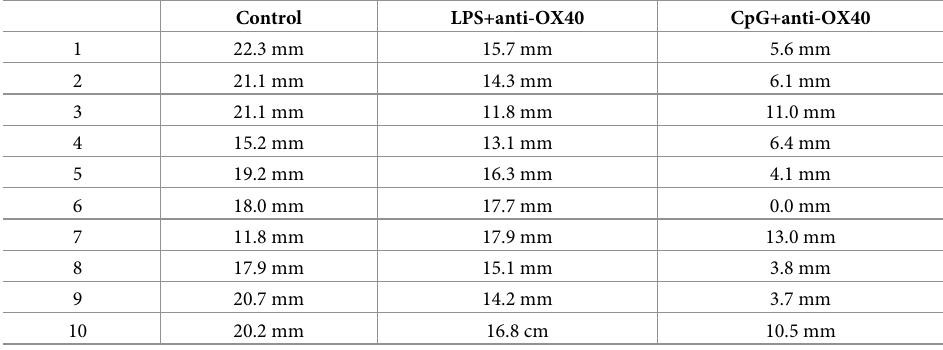
Table 1. Mean tumor diameter (MTD) of the primary tumors (in